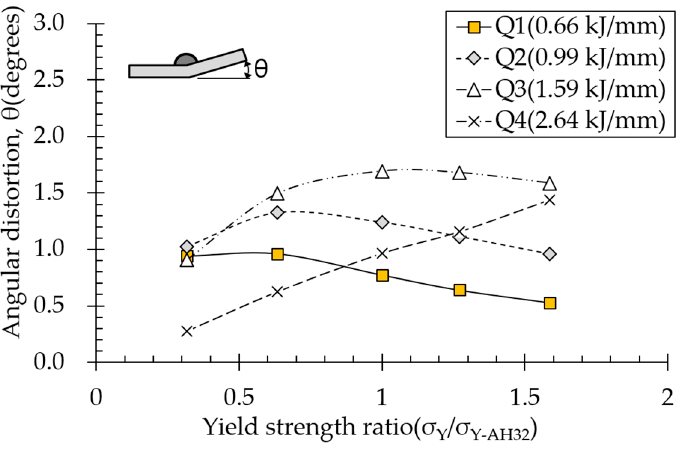
Figure 16. E ff ect of yield strength on angular Figure 16. Effect of yield strength on angular distortion. Figure 16. Effect of yield strength on angular distortion.